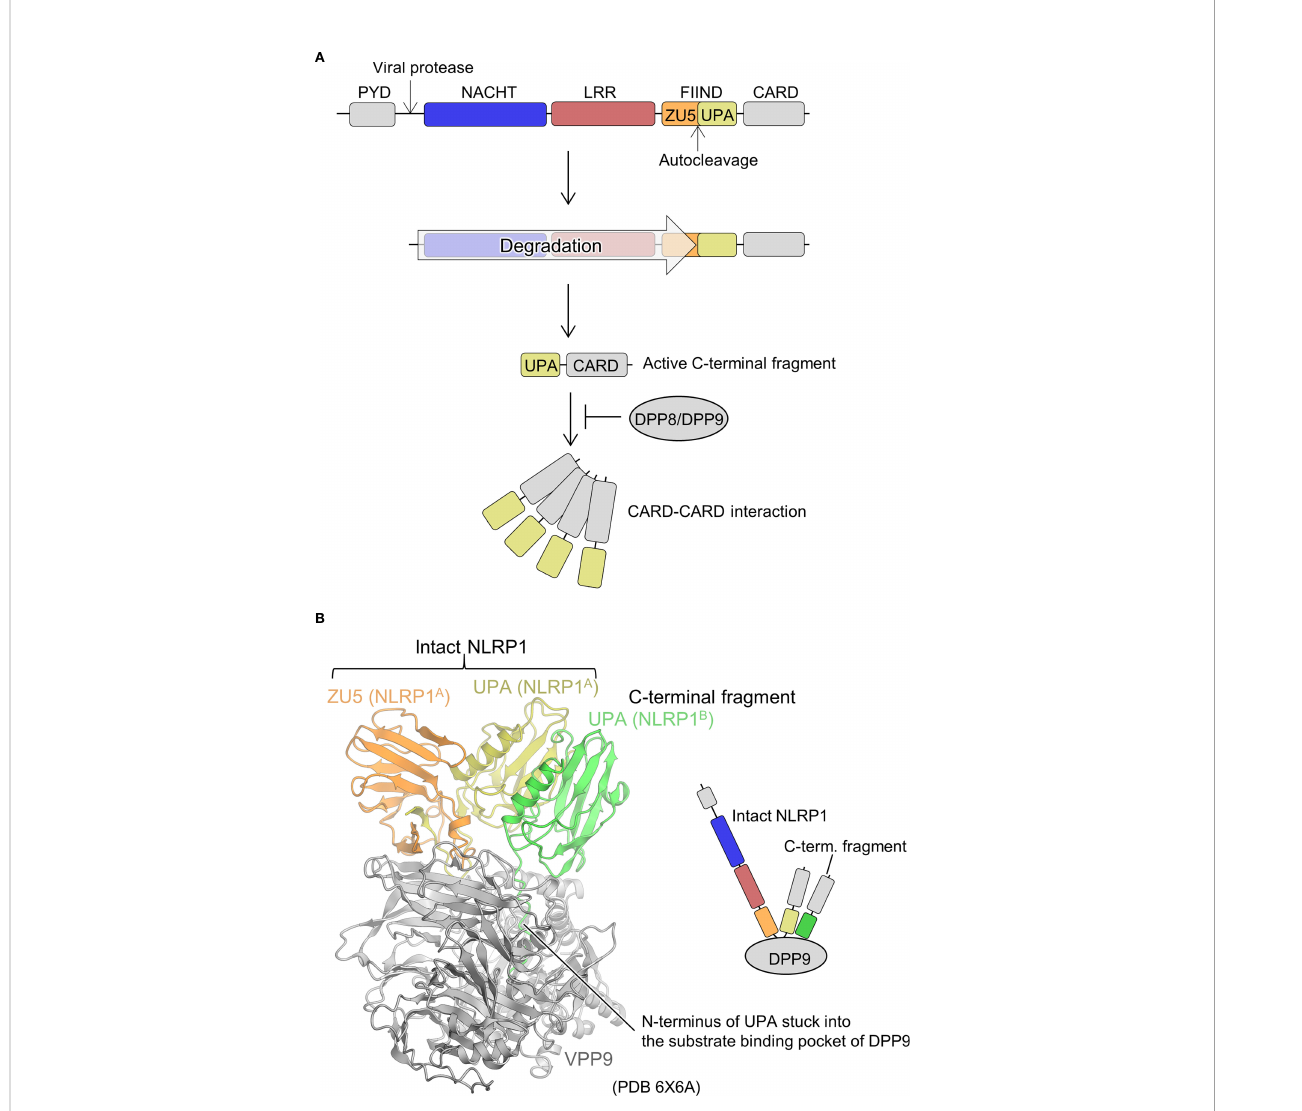
FIGURE 5 Mechanism underlying NLRP1 activation and DPP9-mediated suppression of NLRP1 activation. (A) NLRP1 activation mechanism. The domains are indicated in various colors and are correspondingly represented in Figure 5B. (B) Structure of the DPP9-NLRP1 complex (PDB 6X6A) (28). In the structure, the ZU5-UPA region from intact NLRP1 (denoted as NLRP1 A ) and UPA portion of the C-terminal fragment of NLRP1 (denoted as NLRP1 B ) bound to a DPP9 molecule are indicated. The schematic of the complex is represented in the right